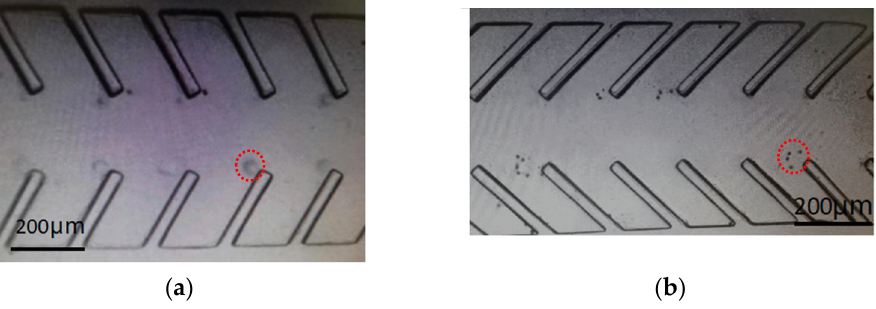
Figure 7. The microscopy images of acoustic streaming around sharp-edge structures: ( a ) Acoustic streaming around sharp-edge structures with an inclined angle of 60° at 20.0 kHz; ( b ) Acoustic streaming around sharp-edge structures with an inclined angle of 45° at 12.8 kHz.